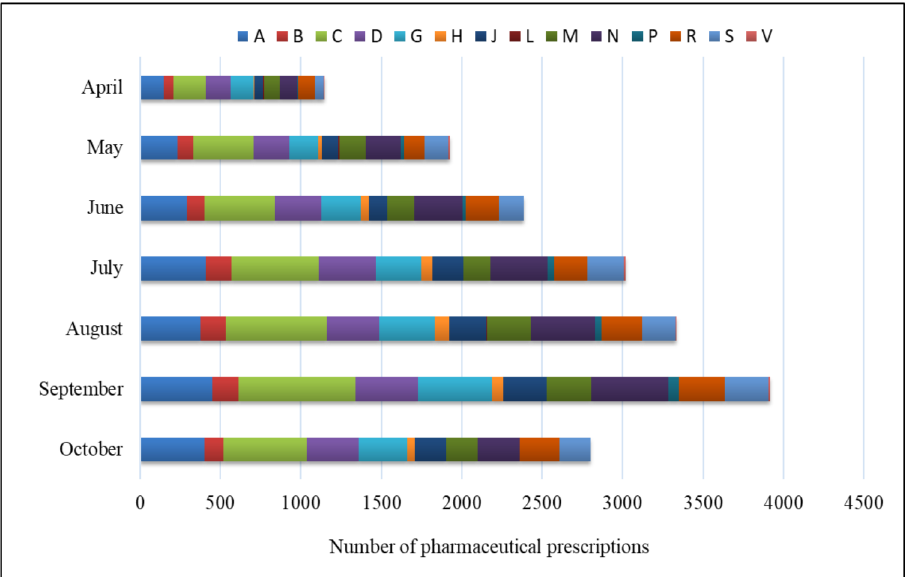
Figure 1. Pharmacist prescribing practices in the Kuyavian-Pomeranian and the types of prescribed